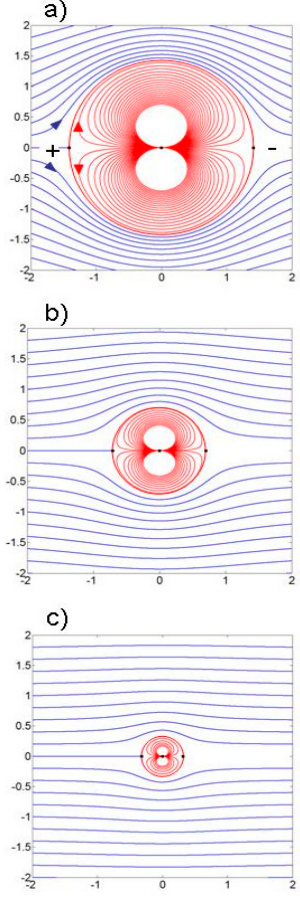
Figure A6. Local revolution time shortens as the radius of the local domain shrinks. The far-field velocity increases as ( a ) Ux* = 1; ( b ) Ux* = 2; ( c ) Ux* = 10. [61].